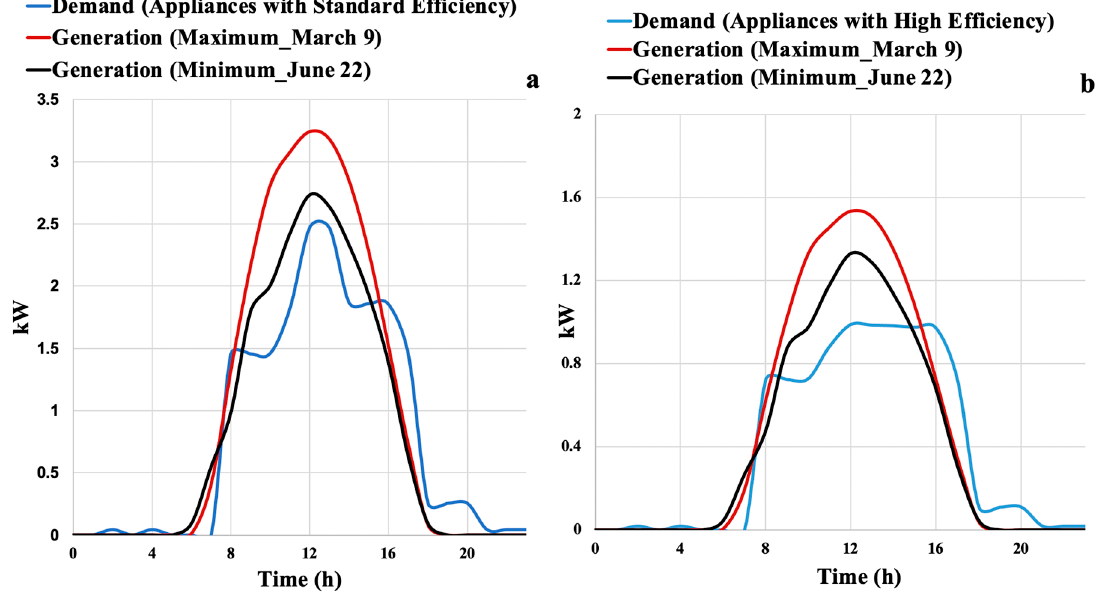
Figure 8. Demand and generation under different load estimation scenarios: ( a ) demand and generation (maximum and minimum) for standard efficiency; ( b ) demand and generation (maximum and minimum) for high efficiency.